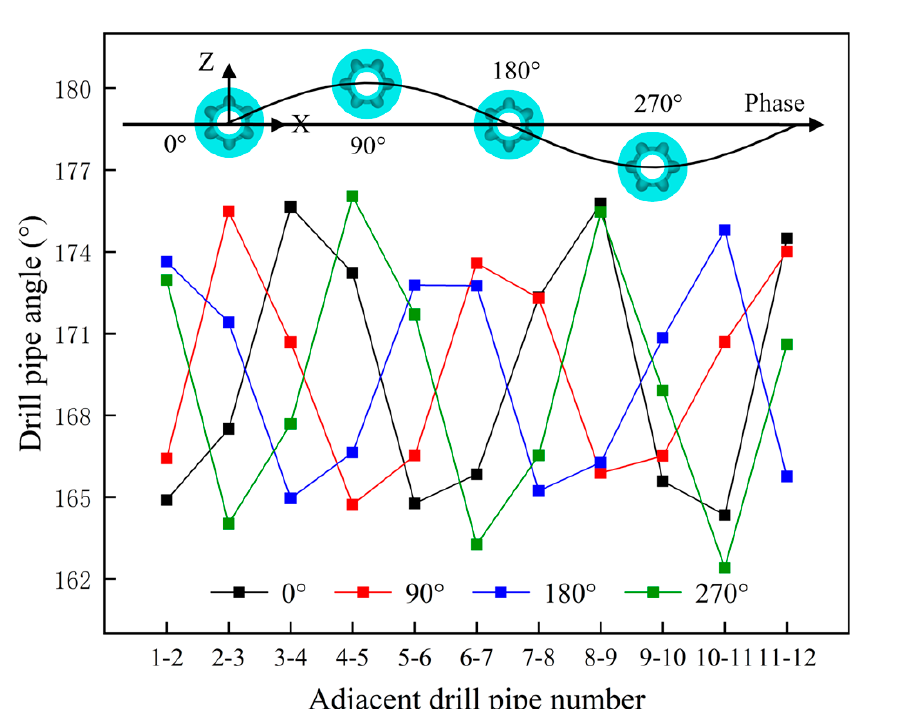
Figure 9. Angle between adjacent flexible joints.